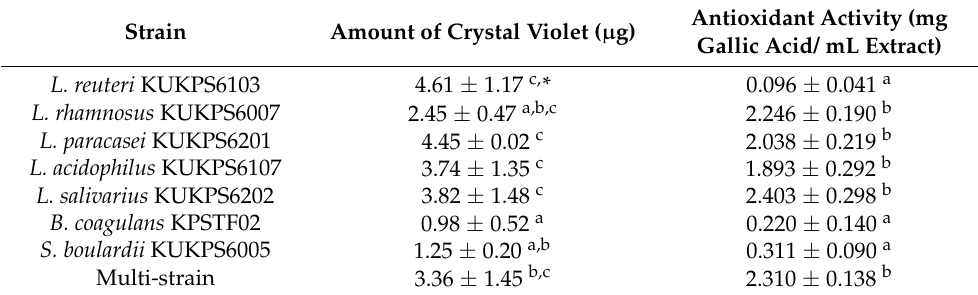
* Values represent the mean ± standard deviation in three independent experiments, n = 3. A different lower case superscript letter in a column represents a significantly different value in statistics using Tukey’s test with a confidential level of